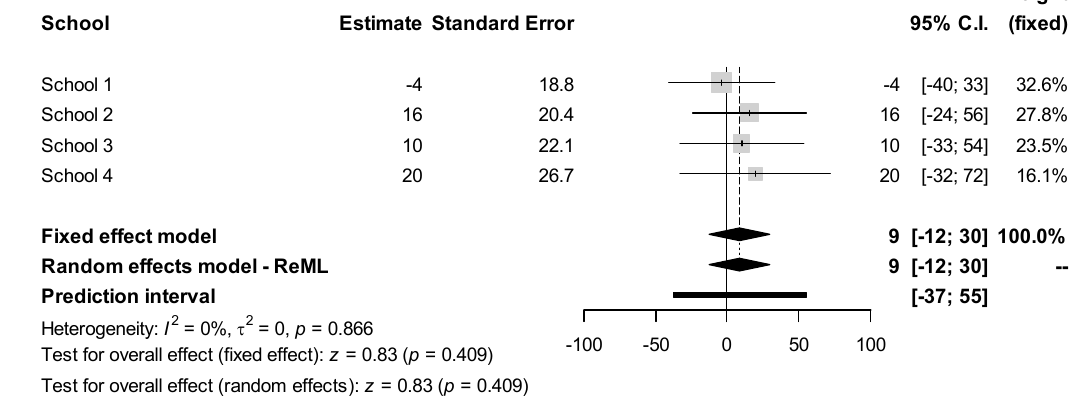
Figure 5. Meta ‐ analysis for test response impulsivity.